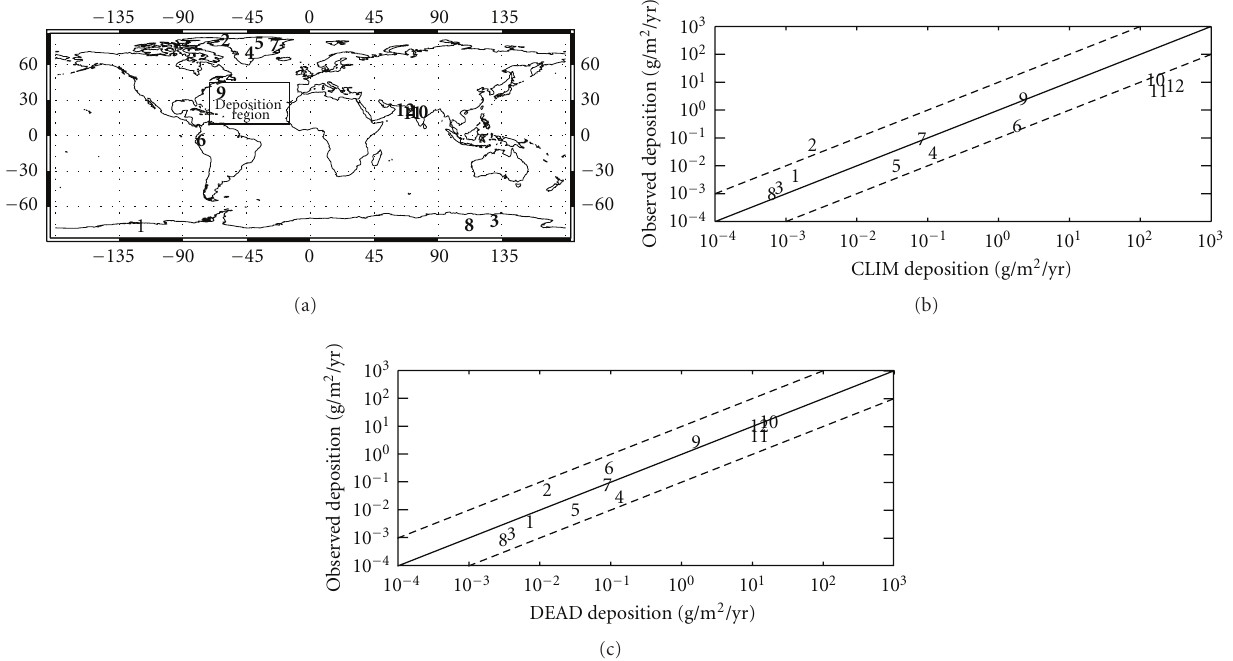
Figure 5: (a) The location of the DIRTMAP stations (1–9, see Table 2) used in this study and scatter plots of the DIRTMAP and nearest model grid box estimated deposition (gm − 2 yr − 1 ) for (b) CLIM and (c) DEAD uplift schemes. Also shown in (a) is the area under consideration for the dust deposition values given in Table 3 and referred to in Section 5.1. Note in (c) that points 10, 11, and 12 lie close to the same point.